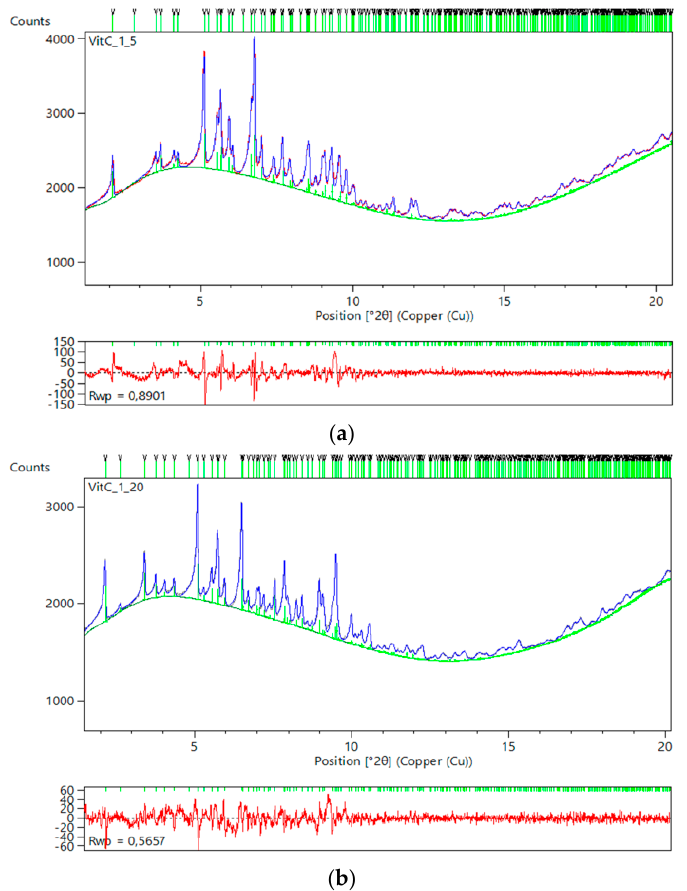
Figure 12. Diffraction patterns of HI cocrystallized with ascorbic acid, in ( a ) T 6 , ( b ) T 3 R 3f insulin conformation, collected using in ‐ house source (X’Pert PRO, λ = 1.541874 Å, RT). The red, blue and lower red lines represent the experimental data, the calculated pattern and the difference between them, respectively. The green bars (upper and lower panel) correspond to Bragg reflections compatible with this particular space group ( R3 ).